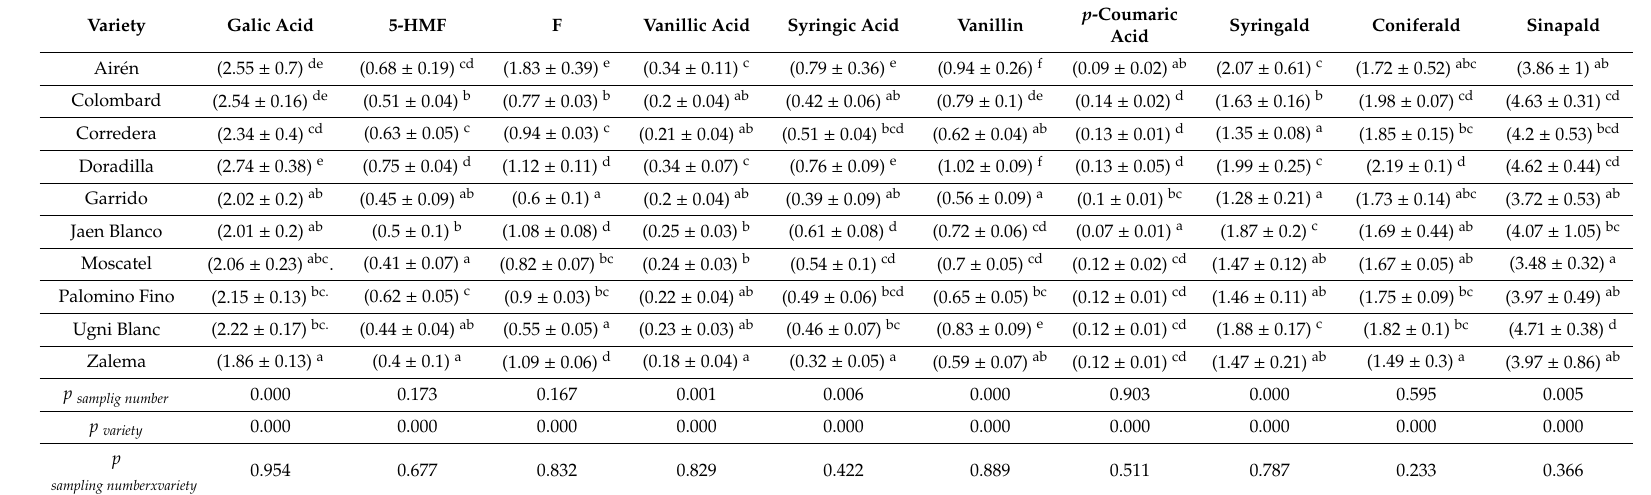
Table 3. Results of the two-way analysis of variance applied to the individual polyphenols. Values for each variety are expressed as average ± standard deviation (in mg L − 1 ). For each variable, identical superscripts indicate that there is no di ff erence between the values for those varieties. (5-HMF: Hydroxymethylfurfuraldehyde; F: